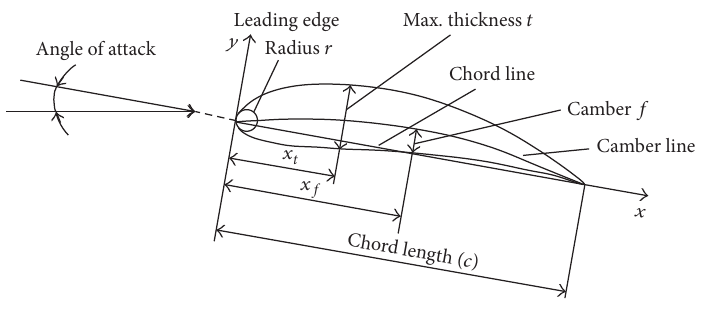
Figure 2: Profile geometry of the bionic airfoil.